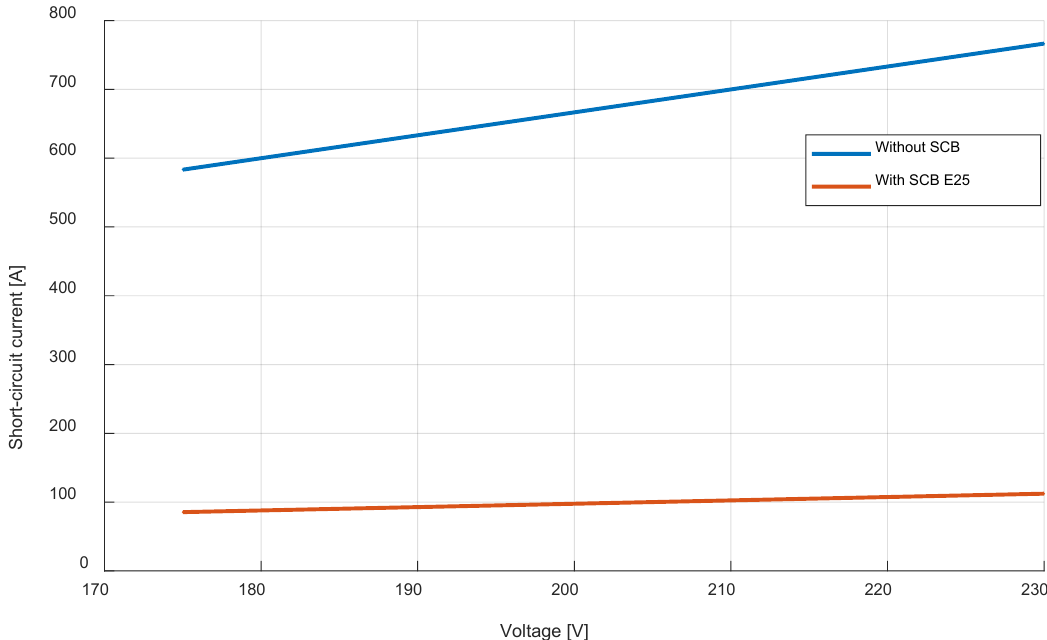
Figure 4. An impact of voltage value on the expected short-circuit currents in installation with (red) or without (blue) selective circuit breaker. T able 2. Coordination table [18].